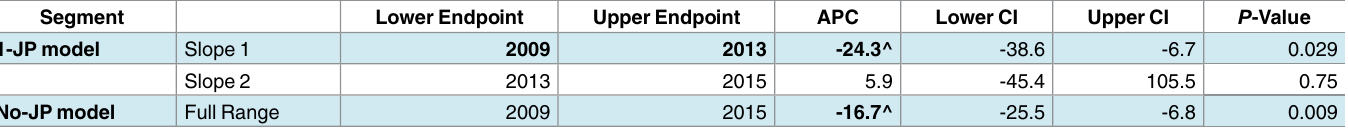
Table 2. The trendsin the inpatientmortalityof JishuitanHospitalat Xinjiekou campus,Beijing,China.